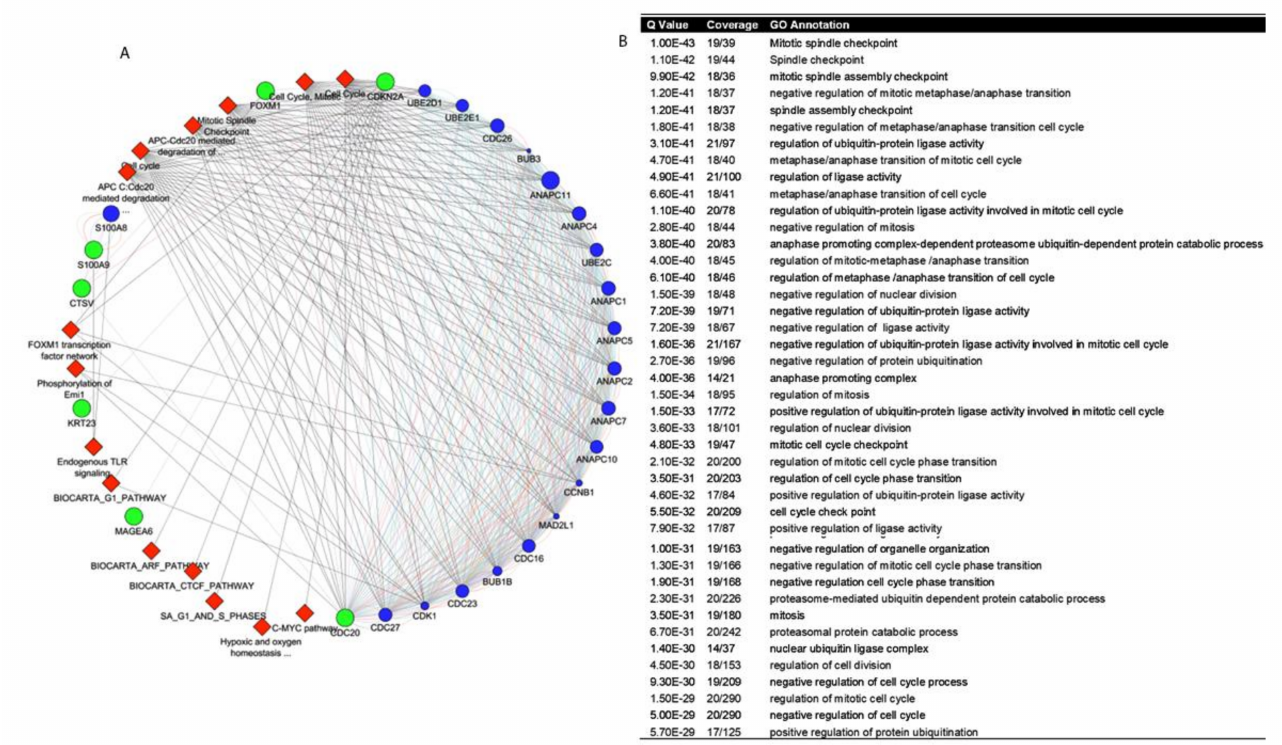
Figure 4. Determination of gene network in bladder cancer. ( A ) PPI network of 1516 overlapping target genes in bladder cancer. ( B ) GO annotation and z-score of the